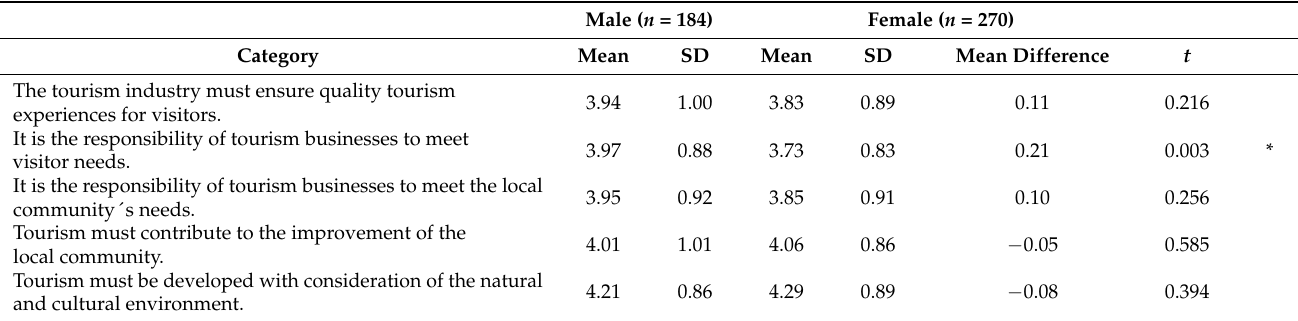
Table 2. Please indicate your level of agreement for the statements below by placing a mark in the corresponding space.